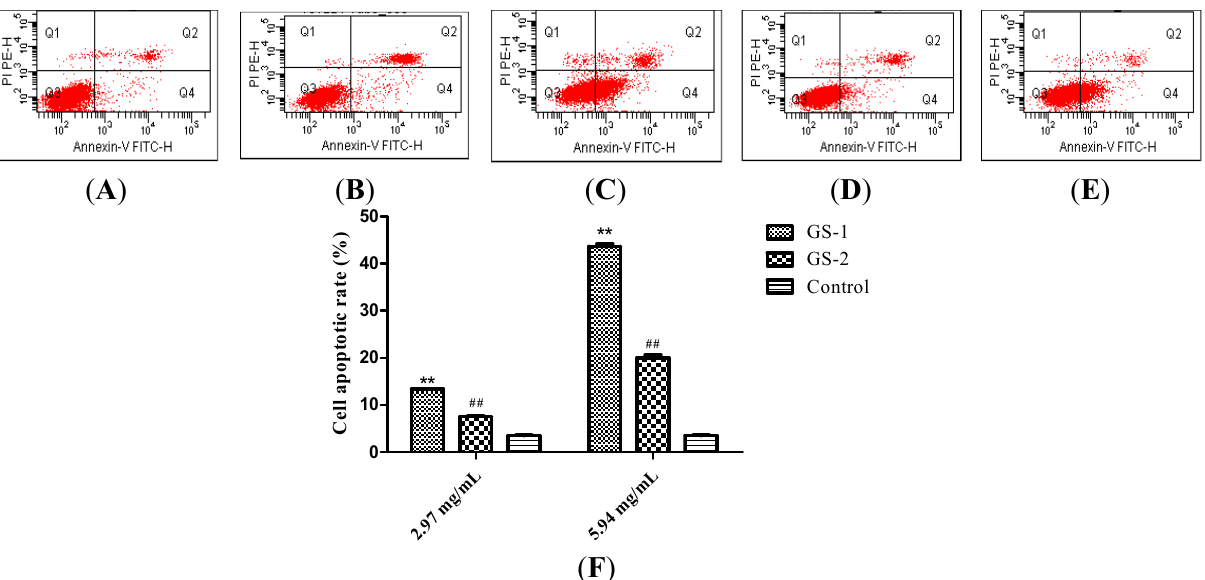
Figure 2. Apoptosis assay using flow cytometer after Annexin V-FITC/PI staining. Control ( A ); LO2 cells were treated with GS-1 at the concentration of 2.97 ( B ) and 5.94 mg/mL ( C ); LO2 cells were treated with GS-2 at the concentration of 2.97 ( D ) and 5.94 mg/mL ( E ); ( F ) Quantification of apoptotic cells, LO2 cells were treated with GS-1 and GS-2 at the concentration of 2.97 mg/mL and 5.94 mg/mL. Values expressed as mean ± SD from three independent experiments, * p < 0.05; and ** p < 0.01 vs. Control; # p < 0.05; and ## p < 0.01 vs.